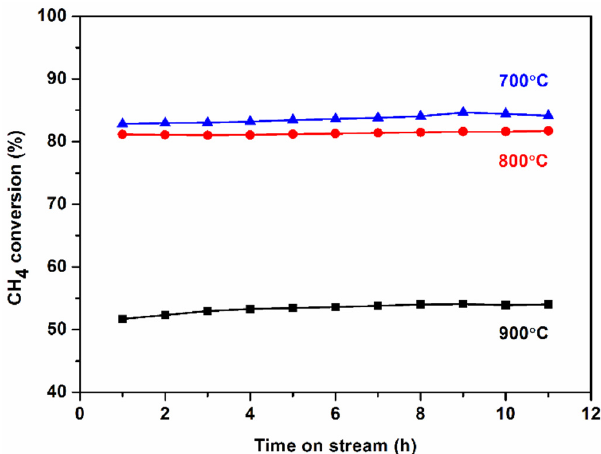
Figure 13. Methane conversion of the catalysts prepared at different calcination temperatures during the POM for 10 h at 750 ◦ C and a gas flow rate of 800 mL min − 1 .